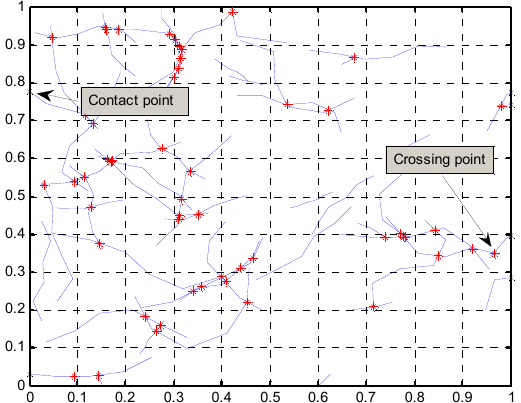
Figure 8. Network of fibers with crossing points between their segments.